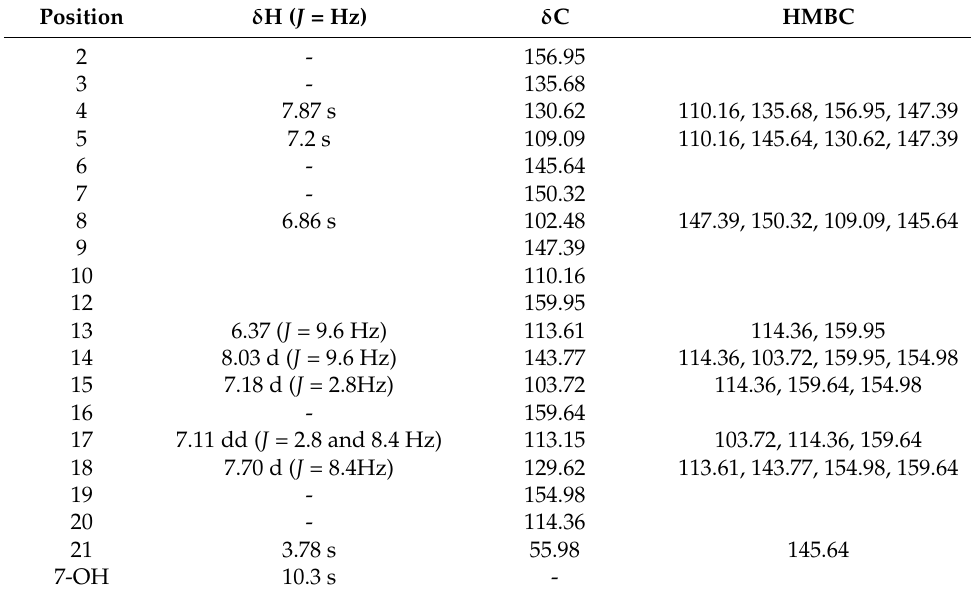
Figure 1. Chemical structure of jusan coumarin. Finally, a methoxy and a hydroxy group were detected as singlet peaks at δ H 3.88 and 10.3, respectively. The 13 C spectrum (Table 1) demonstrated 19 carbon signals, all of them were detected in the aromatic region apart from one methoxy at δ C 55.98 and two conjugated carbonyls at δ C 156.95 and 159.95 that assigned for C-2 and 12, respectively. The two carbonyls were found to be highly up fielded due to the strong resonance effect that counteracts the carbonyls’ anisotropic effect. The HSQC and HMBC (Table 1 and Figure 2) spectra assigned every proton to its carbon. The HMBC spectral data confirmed the proposed structure and indicated the attachment of the methoxy group to the carbon atom C-6 ( δ C 147.39). The molecular formula C 19 H 12 O 7 was determined using HR-ESI-MS experiment, (-ve mode), that showed a pseudo molecular ion peak [M - H] − at m / z 351.0511 (calcd. for C 19 H 11 O 7 , 351.0504). Compound 1 was verified as a dicoumarin because of two reasons. Firstly, the exact 1 H NMR integration values of the protons on each side. Secondly, the presence of only one hydroxyl group at δ H 10.3. Table 1. 1 H and 13 C spectral data of jusan coumarin, 1 , (DMSO, δ